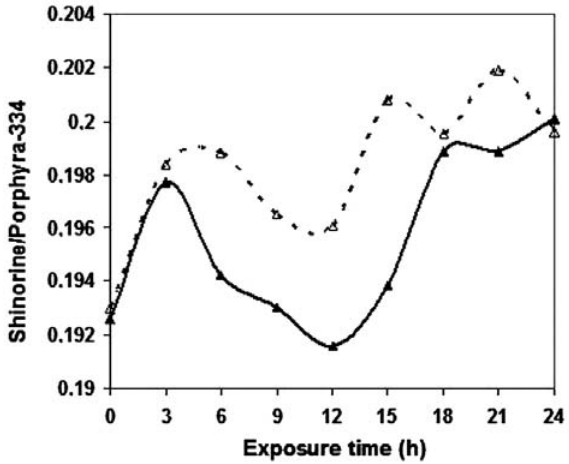
Fig . 7. – Time course of the Shinorine/Porphyra-334 ratio during exposures: Sfixed surface (filled triangles) and vertical mixing (open